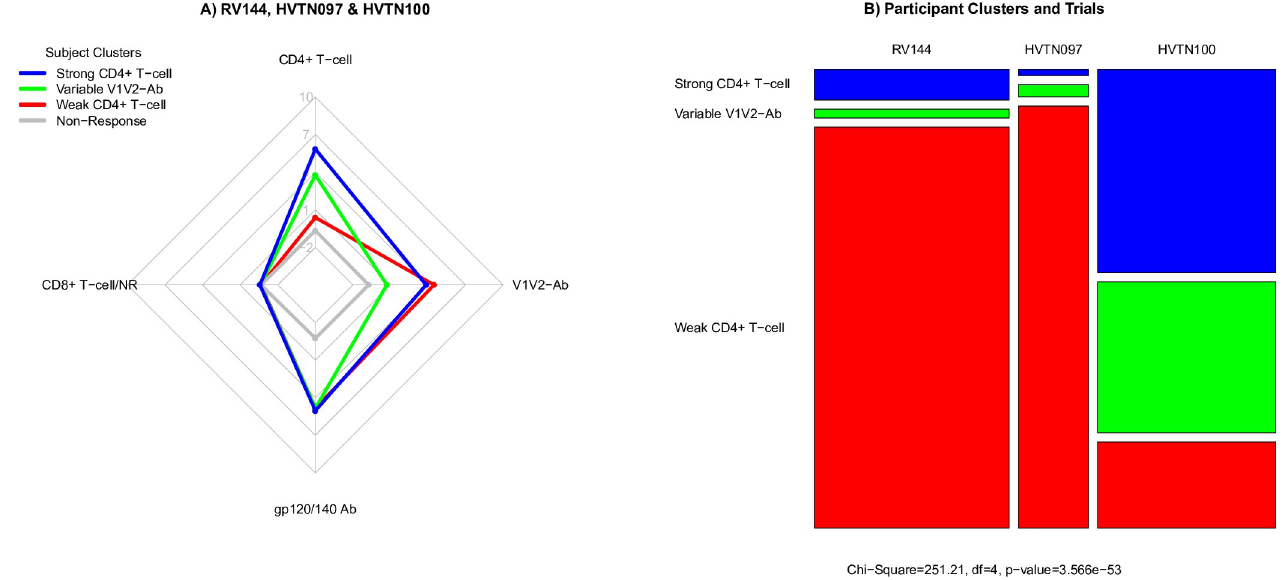
Fig 2. Summary of participant cluster immune response patterns and distribution of participant clusters across studies. A) Radar plot showing the distribution of immune responses in each of the four participant clusters shown in Fig 1. Each colored line represents one participant cluster and each vertex represents an immune response. B) Distribution of participant clusters across the RV144, HVTN 097, and HVTN 100 trials. Each column represents one trial; participant clusters are designated on the left-hand side and are color-coded.